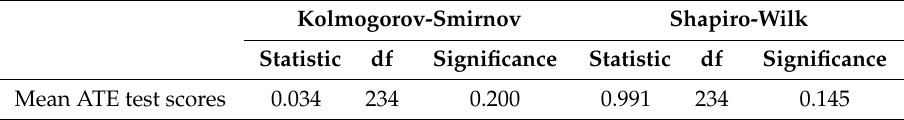
Table 4. Normality